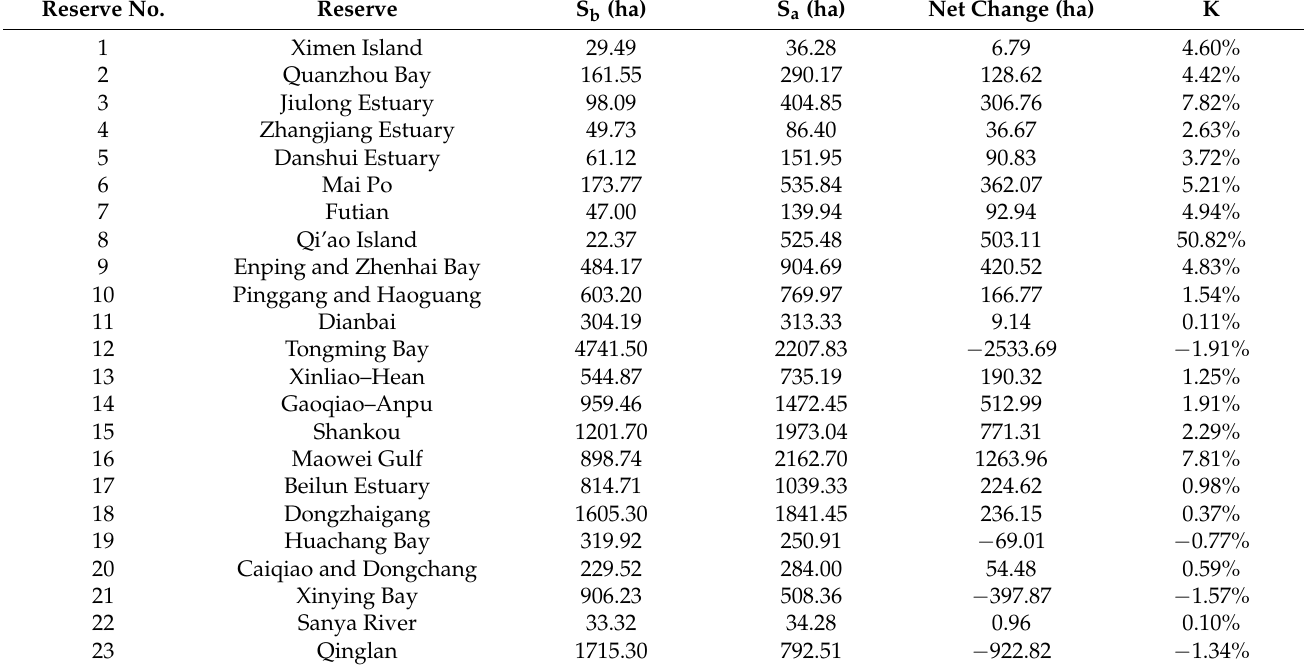
Table 5. Dynamic changes of mangrove area in reserves before and after